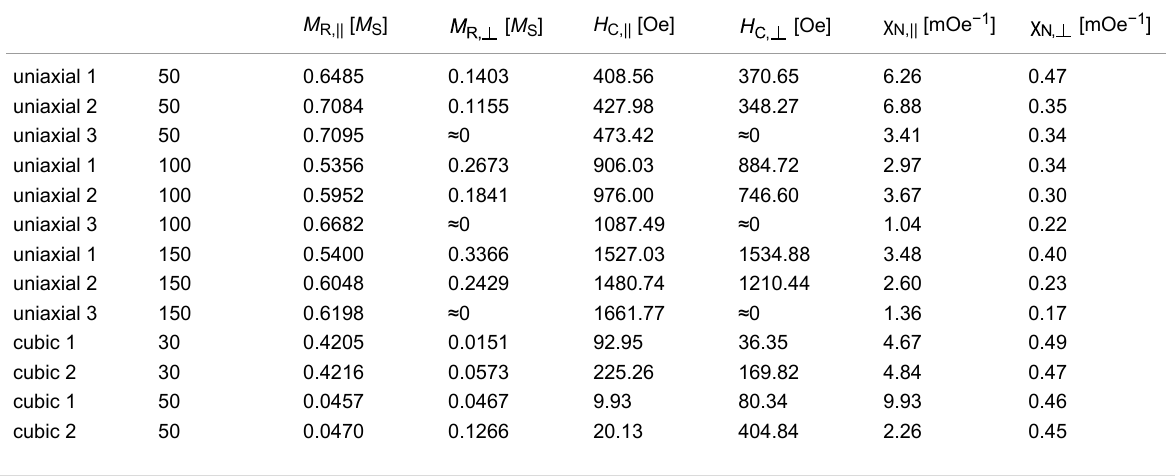
Table 2: Characteristic magnetic data obtained from numerical calculations for different anisotropy cases. The remnant magnetization of particle species II is close to 0, which indicates the superparamagnetic behavior as mentioned before. Sign inversions may be attributed to noise effects such as thermal